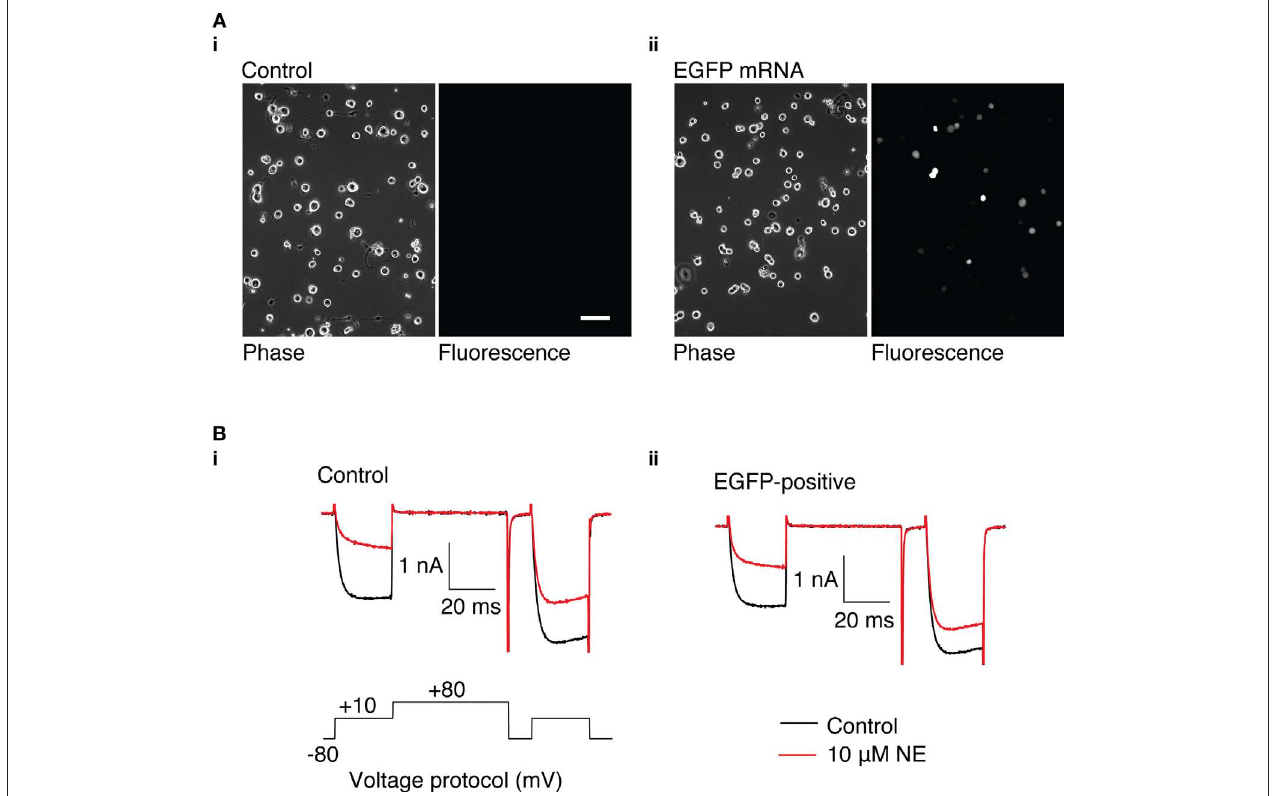
Figure 3 | gFP expression in rat SCg neurons using a suspension-based mrNA transfection technique. (A) (i) Phase and fluorescence image of untransfected SCG neurons. (ii) Phase and fluorescence image of SCG neurons transfected with 3.1 μg GFP mRNA, 16 h after transfection. 100 μm scale bar.